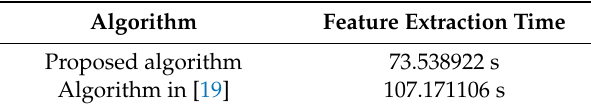
Table 3. Time-consuming comparison of feature